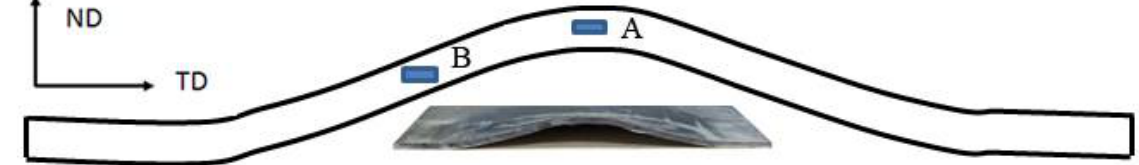
Figure 2. Locations of damped samples detected by electron backscatter diffraction (EBSD).